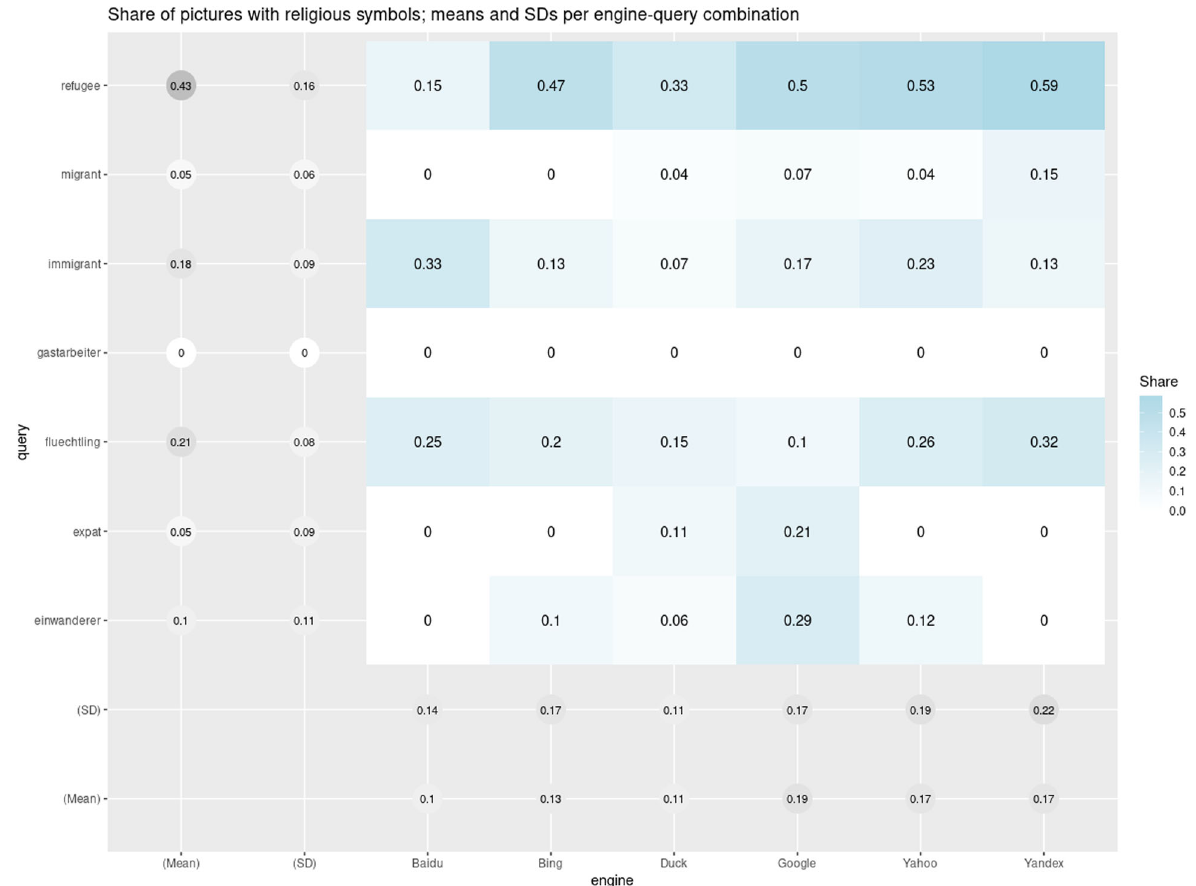
Fig. 7 Share of images with religious symbols. Share of images with religious symbols by search engine and